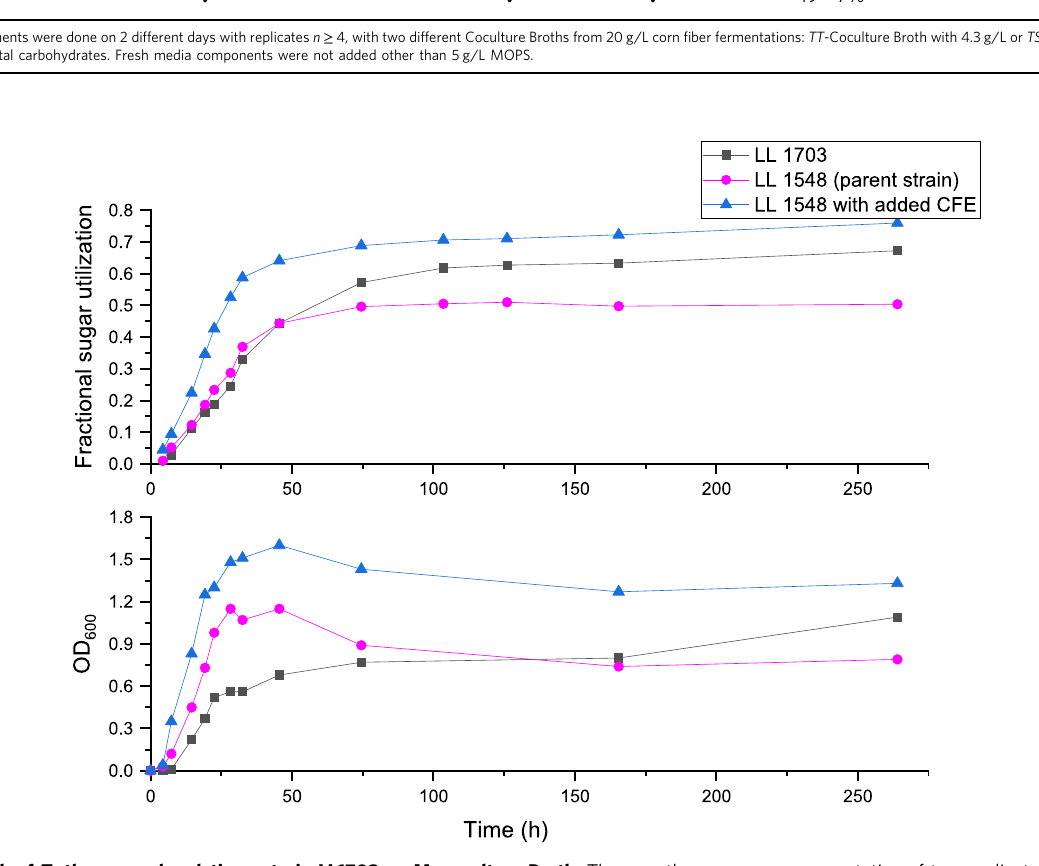
Fig. 5 Growth of T. thermosaccharolyticum strain LL1703 on Monoculture Broth. The growth curves are representative of two replicates. The fi nal % utilization ( n = 6) was 65 ± 2% for the enzyme-expressing strain, 51 ± 1% for the parent stain, and 76 ± 2% for the strain supplemented with enzymes. Red circles — LL1548 (parent strain); black squares — LL1703 (LL1548 expressing four enzymes from LL1355); blue triangles — LL1548 with added LL1703 CFE. Source data are provided as a Source Data fi